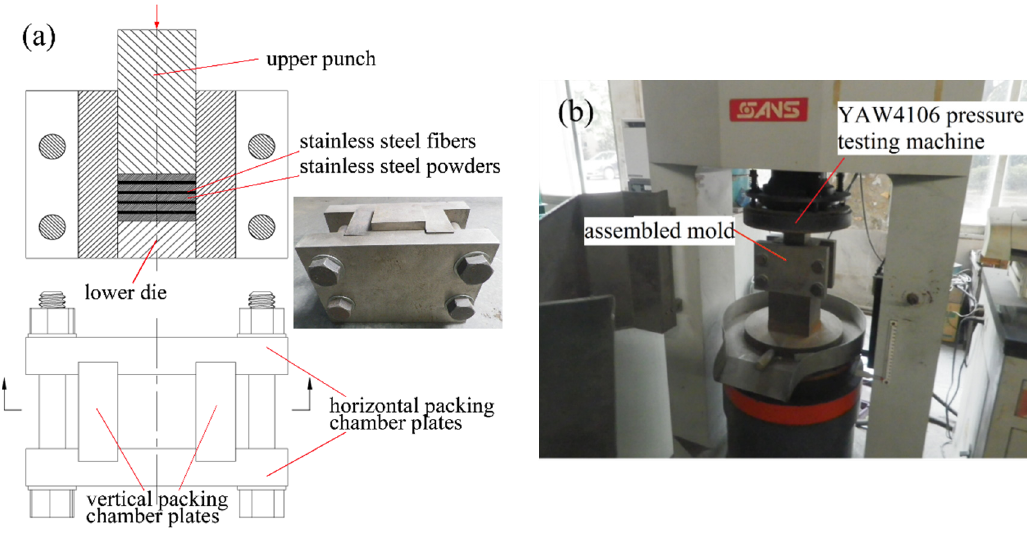
Figure 8. ( a ) The photograph of assembled mold, alternatepowder and fiber layers; ( b ) compaction